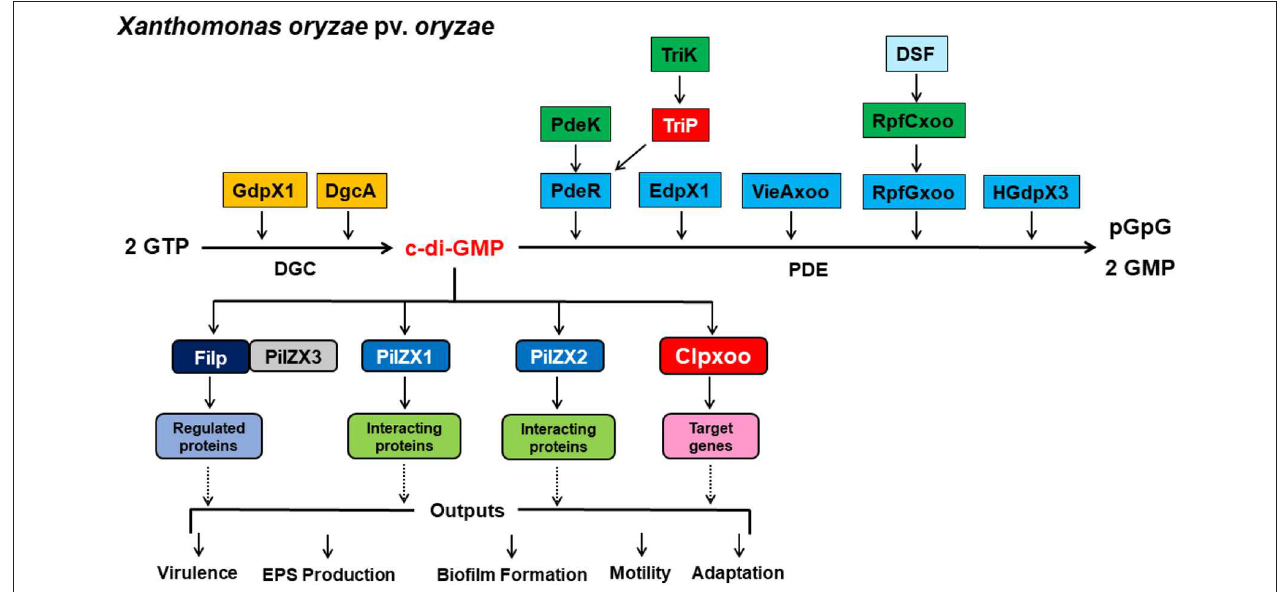
FIGURE 3 | A proposal model outlining c-di-GMP signaling regulation of virulence expression in Xanthomonas oryzae pv. Oryzae. c-di-GMP is a ubiquitous, bacterial second messenger that regulates phenotypes including virulence, EPS production, biofilm formation, motility, and adaptation. c-di-GMP is produced by DGCs GdpX1 and DgcA, and degraded by PDEs PdeR, EdpX1, VieAxoo, RpfGxoo, and HGdpX3. PdeK/PdeR, TriK/TriP, and RpfCxoo/RpfGxoo are 3 pairs of the histidine kinase/response regulator of two component systems (TCSs). c-di-GMP is sensed by receptor proteins Filp, PilZX1, PilZX2, and Clpxoo. Particularly, Filp interacts with PilZX3 for c-di-GMP binding and downstream regulation. Signal receptor and effector proteins then interact with the downstream target proteins or genes to affect a particular cellular function and phenotype, including bacterial virulence, EPS production, biofilm formation, motility, and adaptation at the transcription, post-translation and protein-protein interaction